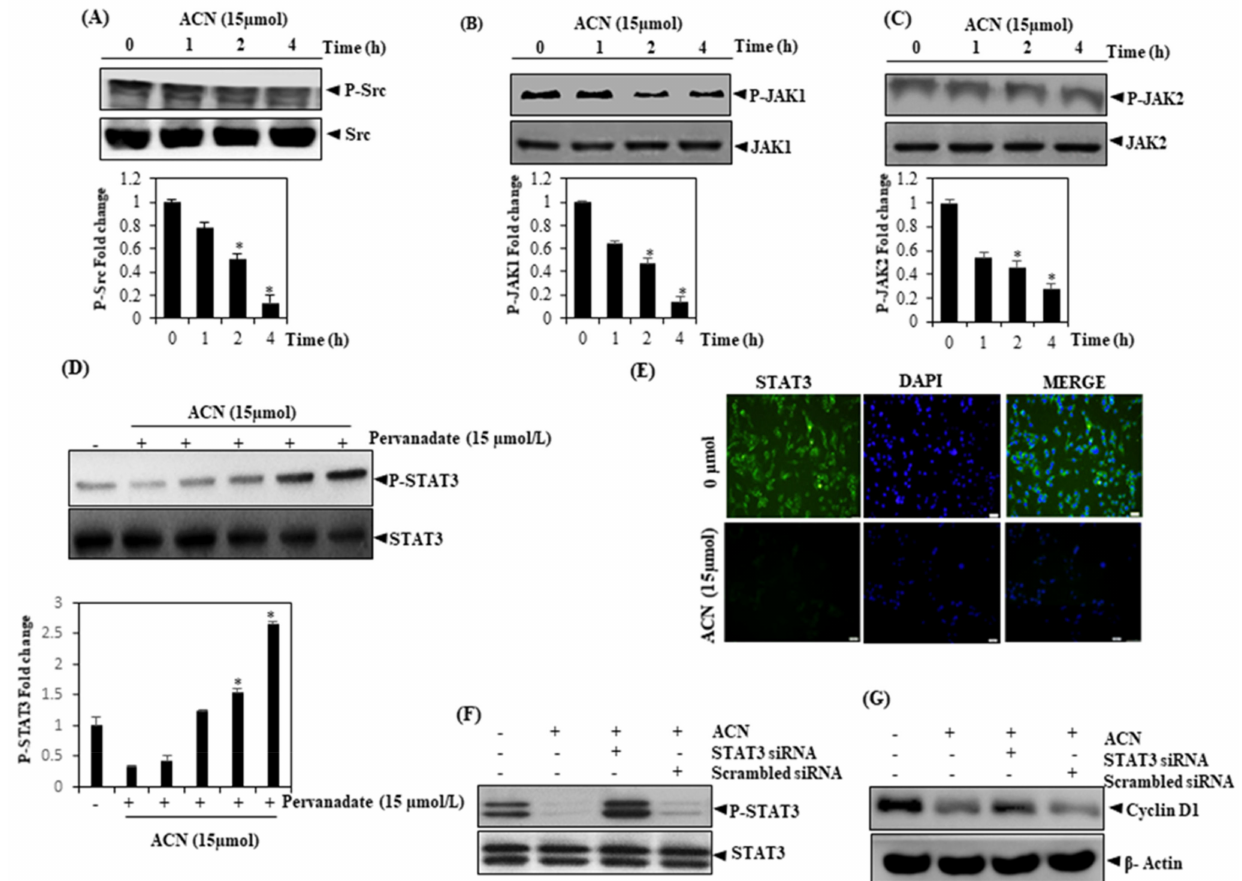
Figure 3. ( A ) Inhibition of constitutively active STAT3 by ACN. After exposing HepG2 cells to 15 µ mol/mL of ACN, extracts of the entire cells were taken. Then, 30 mg aliquots of the extracts were resolved on SDS-PAGE gel (10%) before being transferred to nitrocellulose membranes, eventually being examined using the p-Src antibody, and blots were in turn stripped and re-investigated to confirm equal protein loading. ( B ) ACN suppresses p-JAK1 levels in a time-dependent manner, and p-JAK1 is examined using an pJAK1 antibody. JAK1 antibody was stripped and re-investigated for ascertaining equality in protein loading. ( C ) p-JAK2 levels were also investigated using a p-JAK2 antibody and found to be suppressed in a time-dependent manner. This step assumes significance. ( D ) The suppression of p-STAT3 by ACN is reversed by pervanadate. Extracts of the cells were